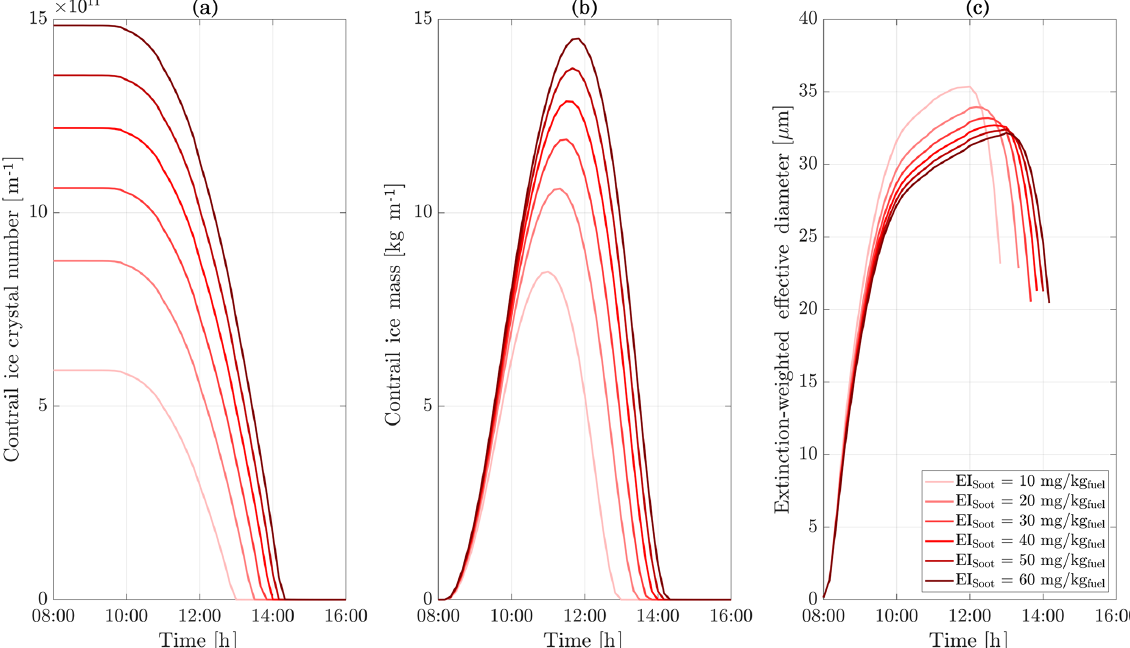
Figure 12. Total contrail ice crystal number (a) , ice crystal mass (b) , and extinction-weighted effective diameter (c) for different black carbon emission indices. A background relative humidity of 110% and a temperature of 217K at flight level are assumed.